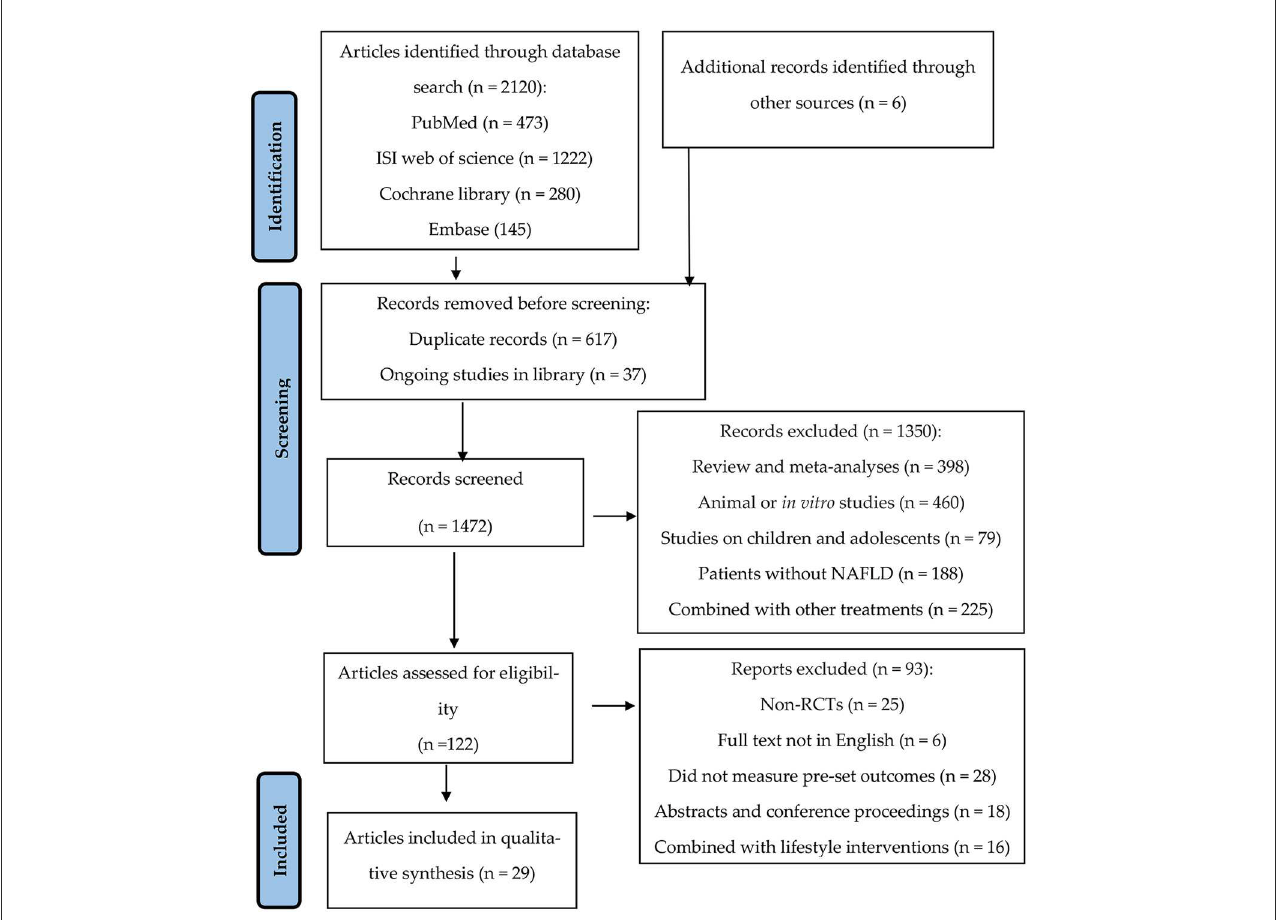
FIGURE1 Preferred reporting items for systematic reviews and meta-analyses (PRISMA) flow diagram detailing the study selection process for systematic literature